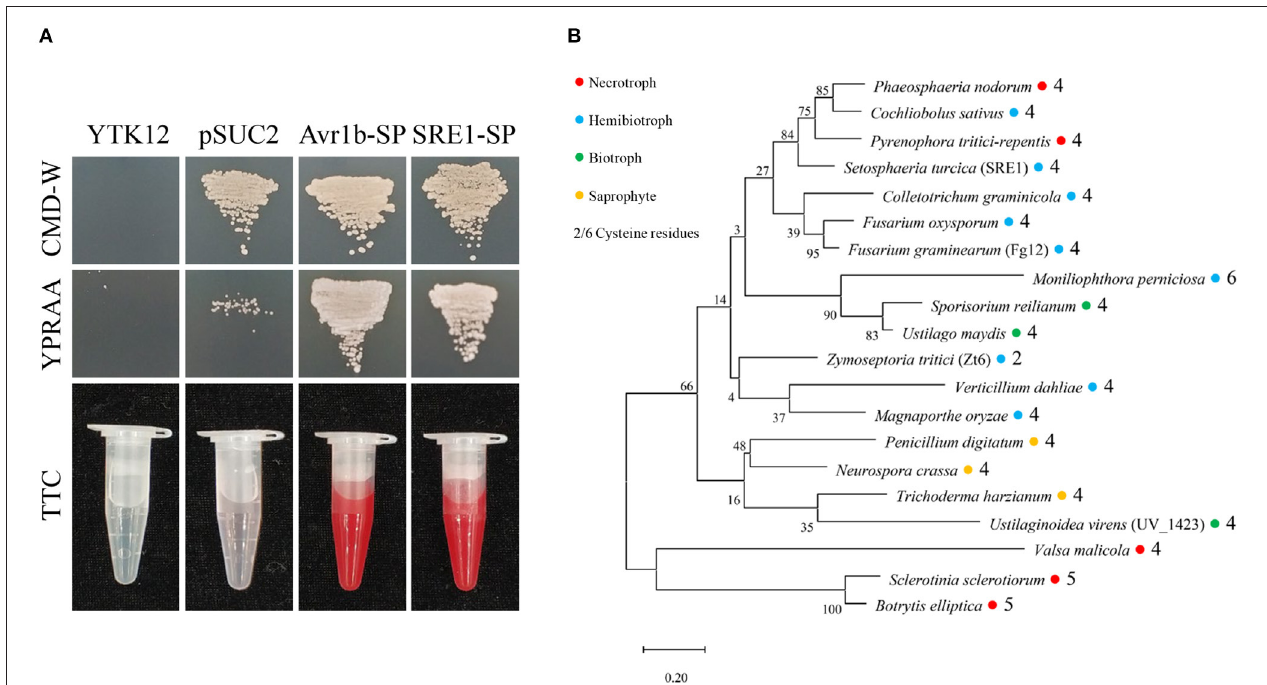
FIGURE 2 | Secretory function and phylogenetic analysis of S. turcica effector SRE1. (A) The yeast-signal peptide trap system was used to verify the signal peptide function of SRE1. A CMD-W medium screened the yeast strain YTK12 carrying the pSUC2 vector. The signal peptide with secretion function can make up the secretion defect of YTK12 invertase so that YTK12 can grow in the YPRAA medium. The invertase activity was detected by reducing TTC to insoluble red TPF. The Avr1b-SP and the empty vector pSUC2 were used as positive and negative controls, respectively. (B) Phylogenetic tree of SRE1 homologs in fungi of different trophic types. The sequences were derived from the Uniprot database and aligned using CLUSTALW. The phylogenetic tree was constructed in MEGA. The colored circles represent different trophic types of fungi, and the numbers represent the number of